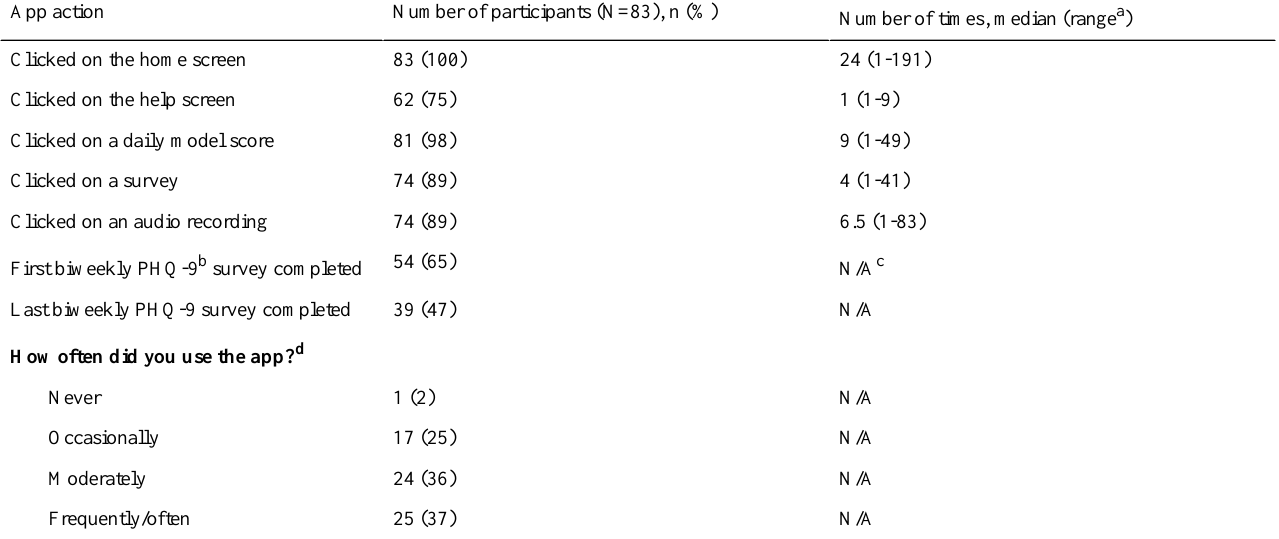
Table 2. Cogito Companion app use over the 3-month study period.